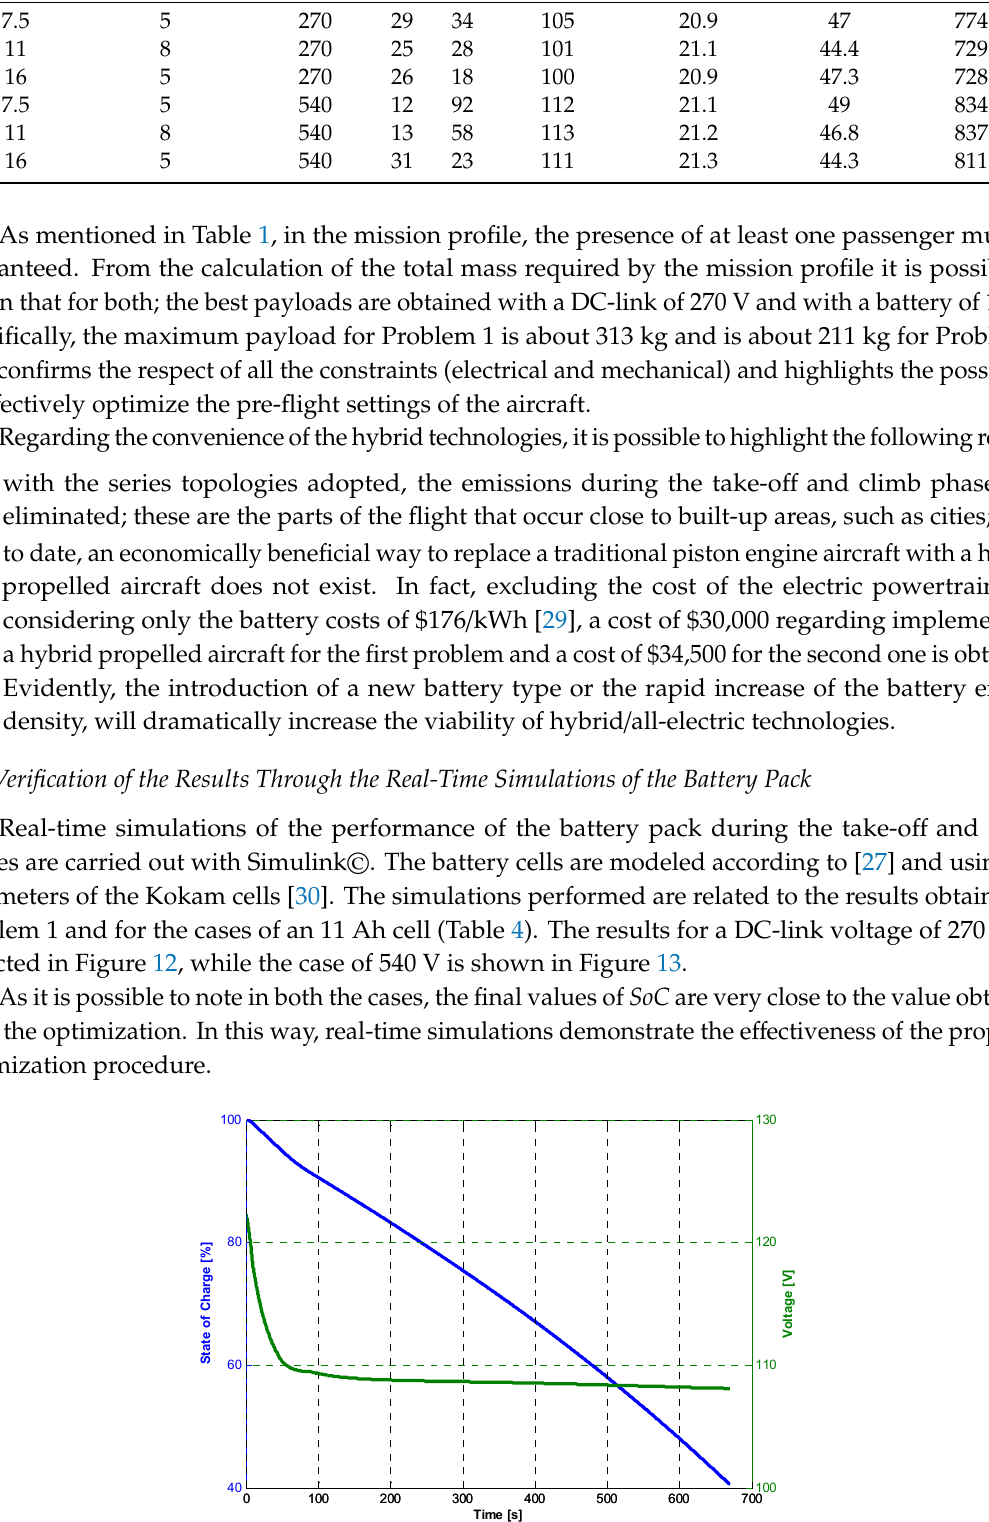
Figure 13. Real-time simulation of the case 11 Ah, n p = 21, n s = 29, 540 V on the DC-link: SoC (blue line) and output voltage (green line). 7. Conclusions All electric aircraft and the hybrid electric aircraft are currently feasible technologies which can be applied to UAVs and passenger aircraft. A crucial problem is the correct integration and sizing of the storage systems utilized on board. This factor influences the performance of the aircraft in terms